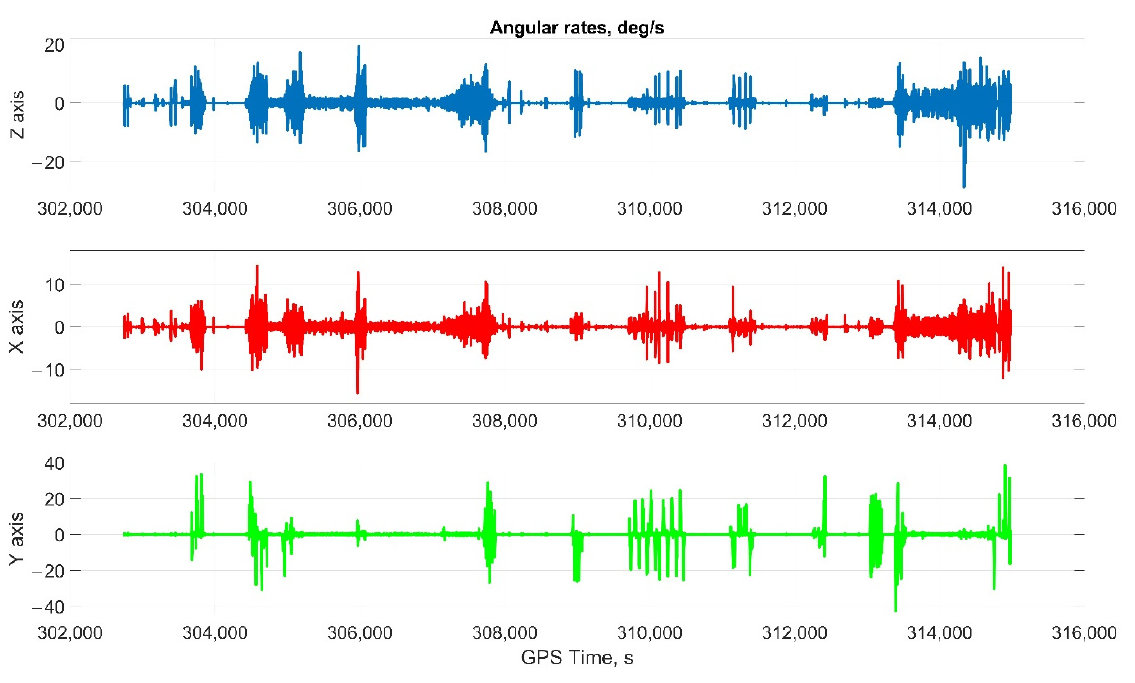
Figure 8. The angular rates in the projections onto body frame in car test (X, lateral axis; Y, longitudinal axis; and Z, completes the right-handed system, up axis when OXY is horizontal plane).